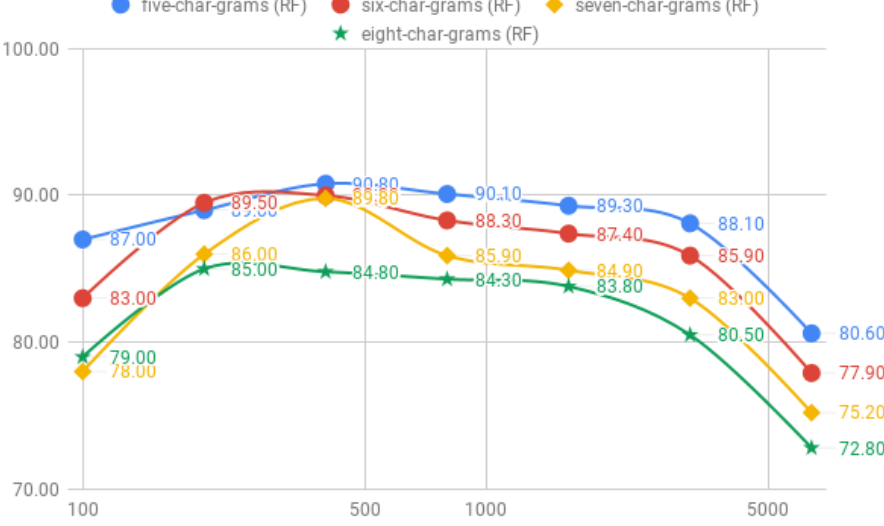
Figure 8. Comparison of the accuracy between five-, six-, seven- and eight-char-grams for the RF